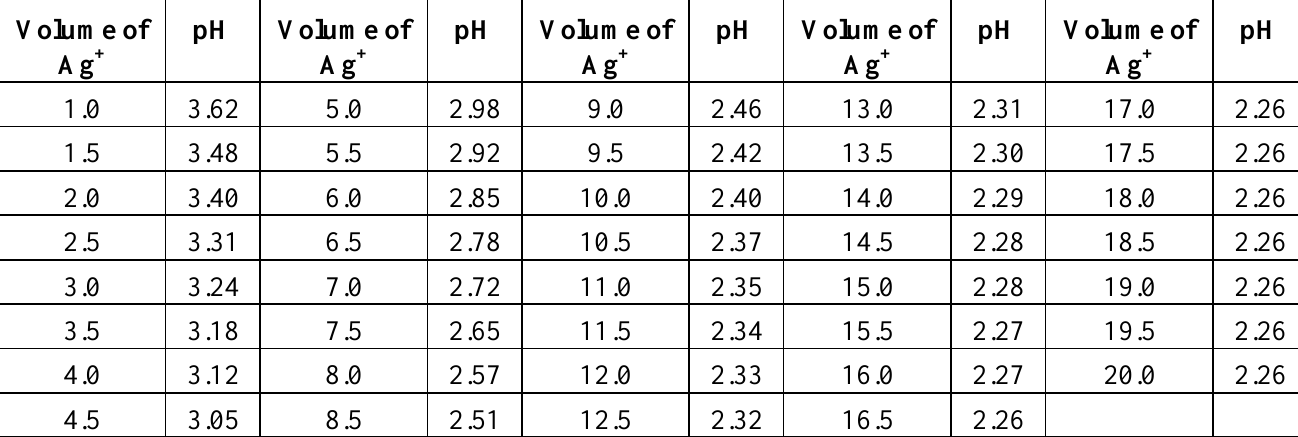
Table 2. Volumes of silver nitrate (0.01 M), and the relevant